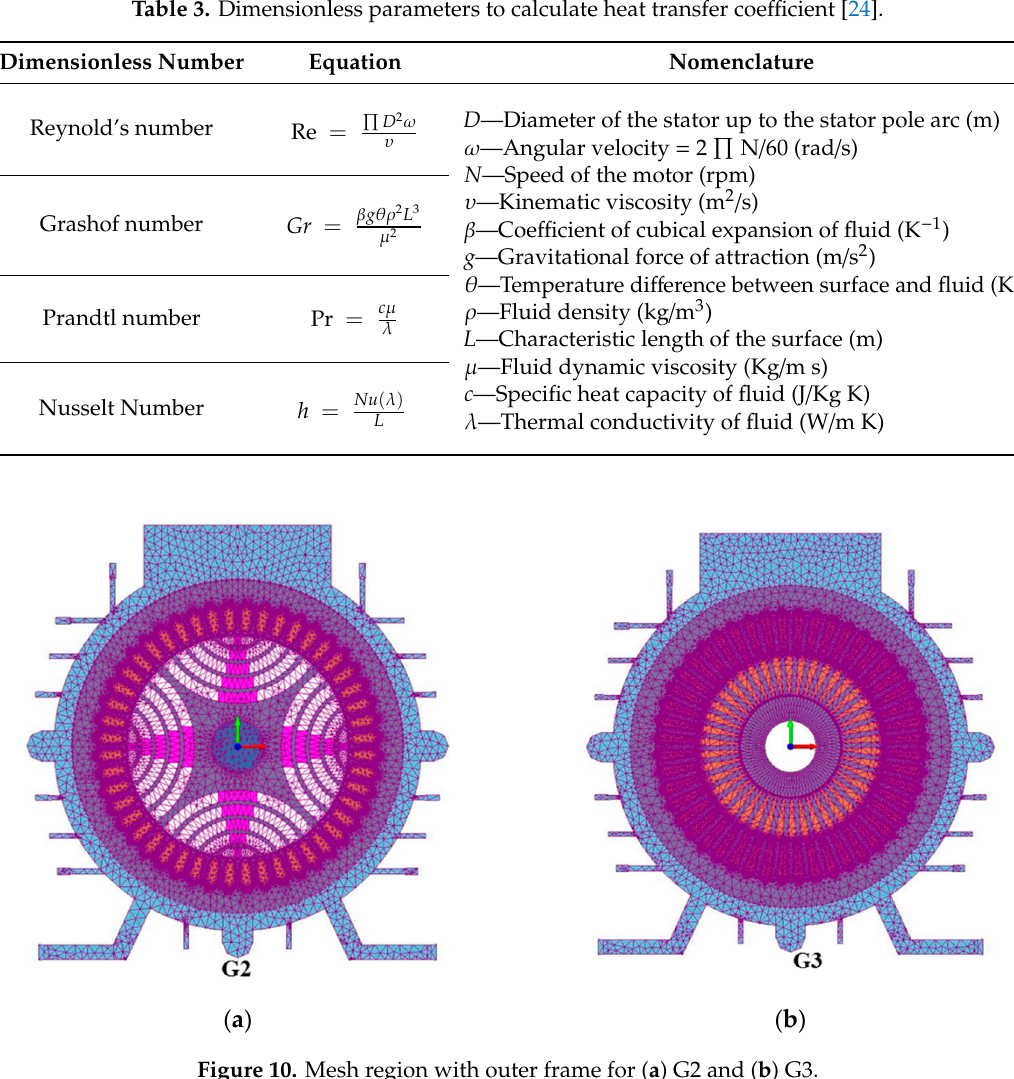
Table 3. Dimensionless parameters to calculate heat transfer coefficient [24].